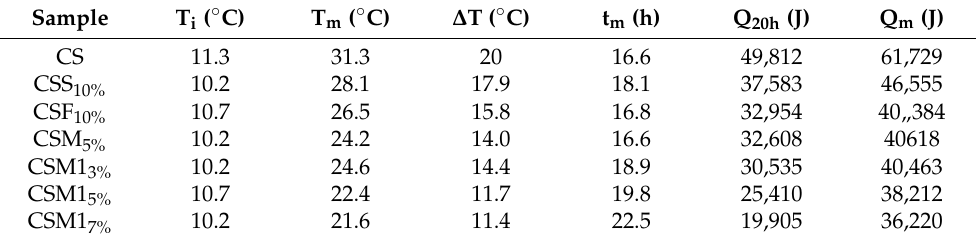
Table 8. Temperature and heat of hydration data for cement